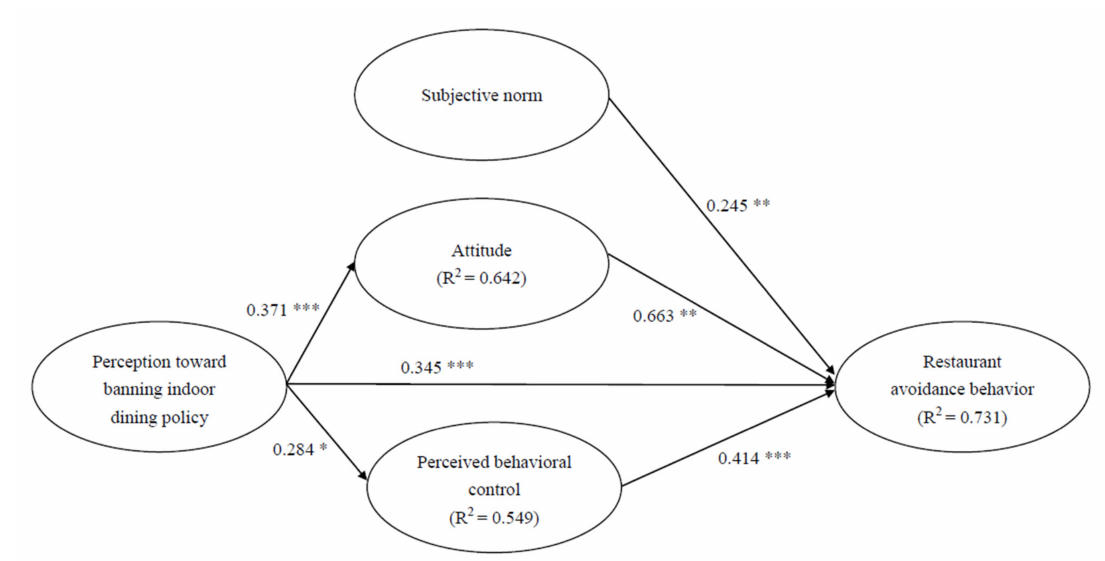
Figure 2. Path Coefficient Analysis * p < 0.05, ** p < 0.01, *** p <